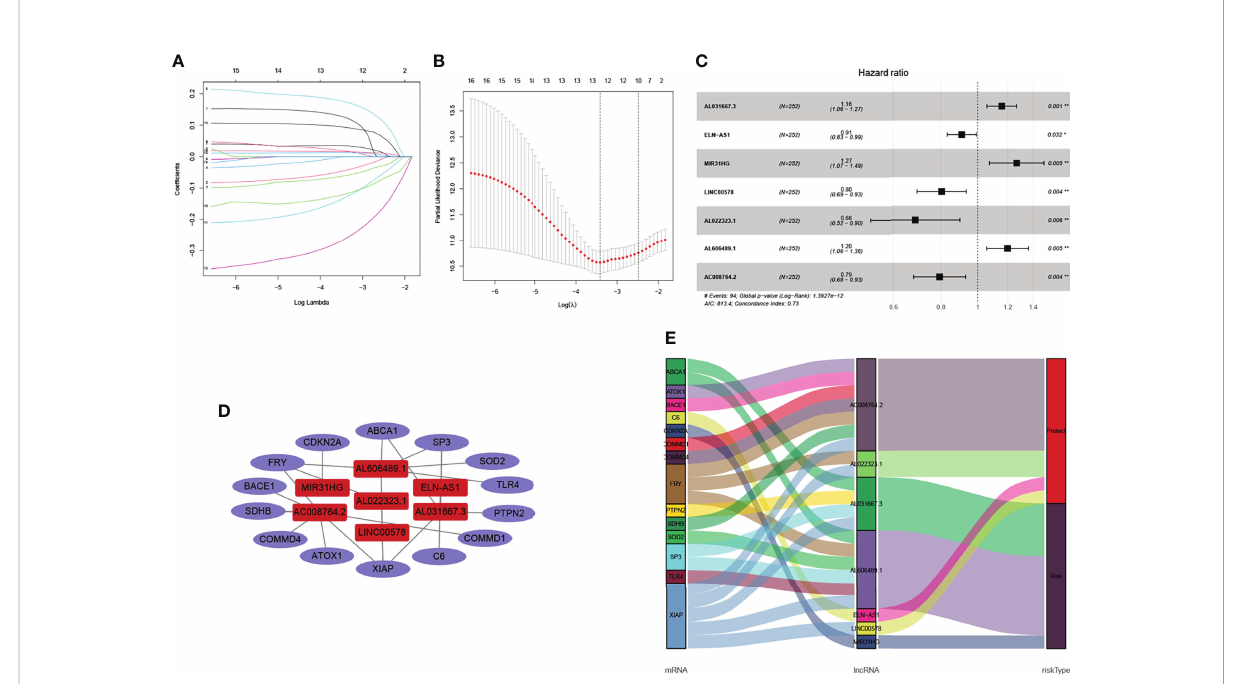
FIGURE 3 Identi fi cation of cuproptosis-related lncRNAs and co-expression network construction. (A, B) LASSO Cox algorithm was employed to establish a prognosis model. The color depth of the nodes depicted the corrected P -value of ontologies. The size of the nodes depicted the number of genes that are engaged in the ontologies. (C) A total of 7 lncRNAs were selected through subsequent multivariate analysis to construct the risk model. (D) Co-expression structure between cuproptosis-related lncRNAs and genes. (E) Sankey diagram was used to visualize the co- expression